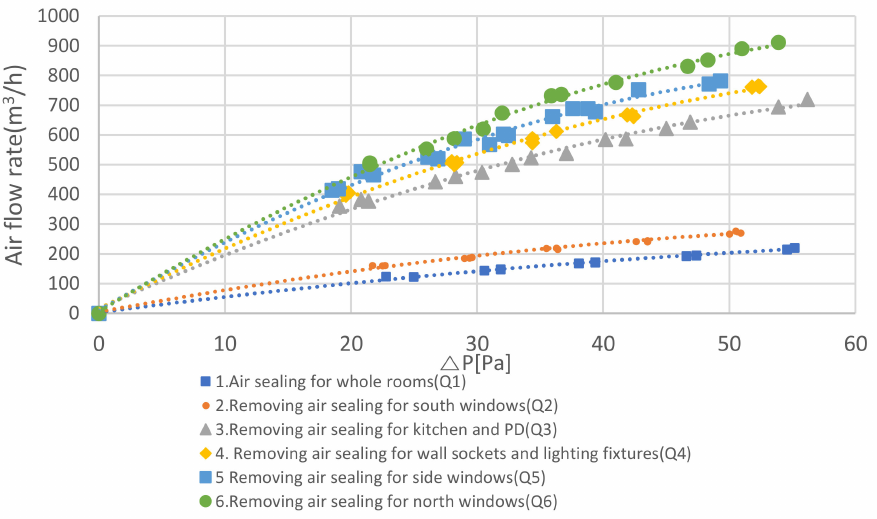
Figure 4. Blower door test data for the six measurement